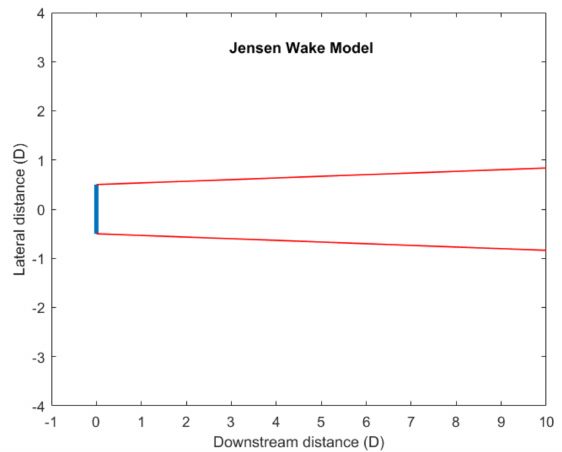
Figure 9. Jensen wake model implemented in